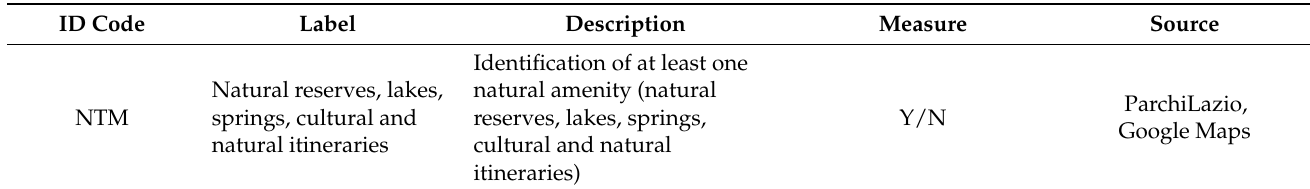
Table 2. Variables used in the multidimensional analysis. Author’s own